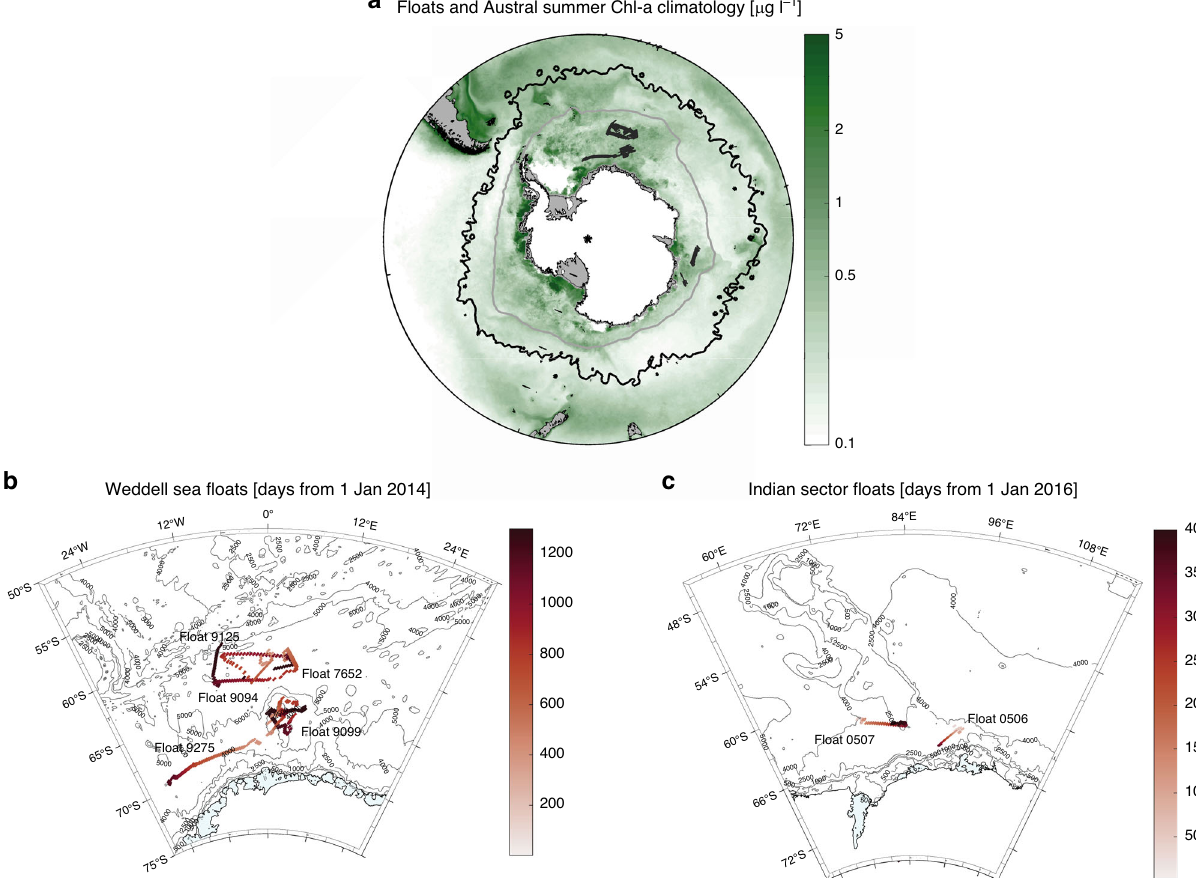
Fig. 1 Floats trajectories in the sea-ice zone. Maps of the fl oat trajectories overlying the MODIS chlorophyll austral summer climatology (2002 – 2018) in a and as a function of pro fi le days in b the Weddell Sea and c the Indian sector of the Southern Ocean. In a , the grey line is the climatological sea-ice extent in September (1978 − 2017) and the black line is the northern jet of the sub-Antarctic Front (SAF-N) as de fi ned in Ref. 70